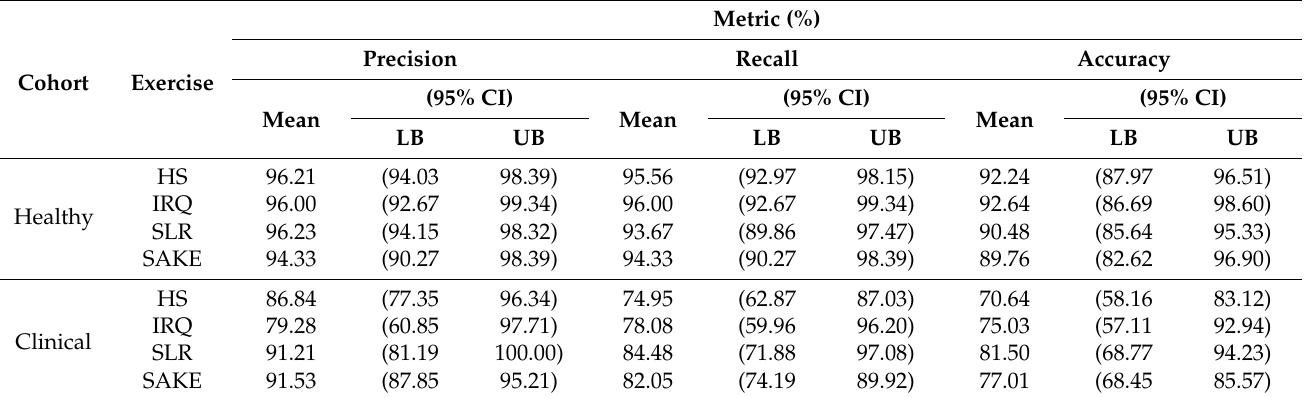
Table 6. Segmentation model performance with use of the test data.